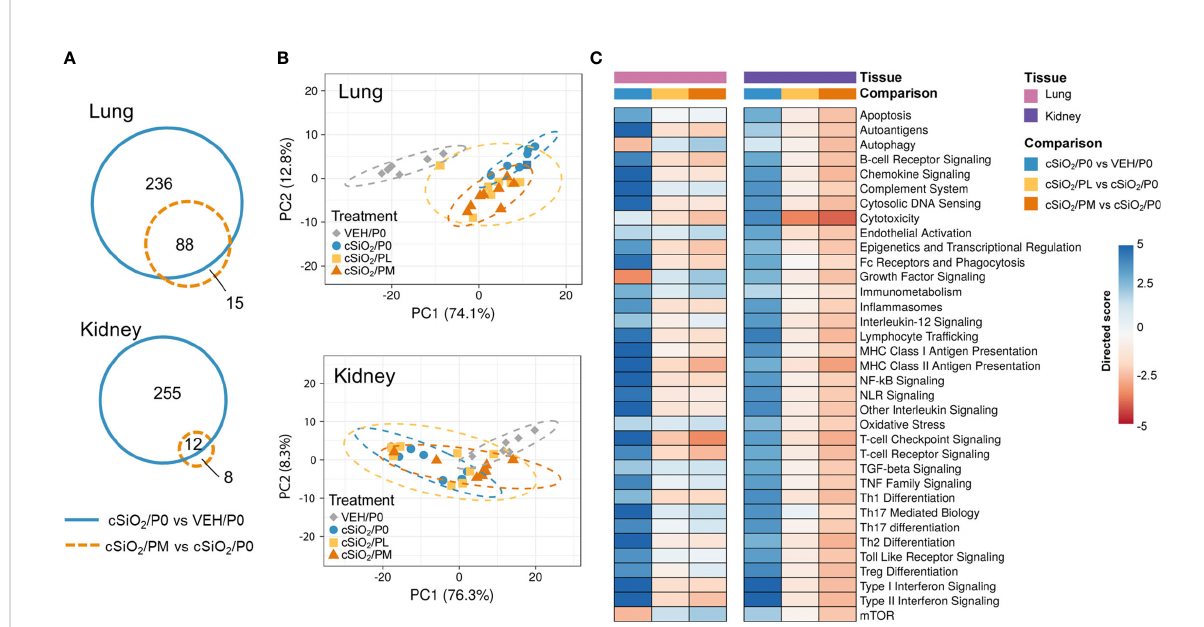
FIGURE 6 Effect of prednisone treatment on cSiO 2 -induced transcriptional changes in lung and kidney tissues of mice 14 weeks post instillation. (A) Venn diagrams depicting overlap of genes differentially regulated in mice with cSiO 2 /P0 vs VEH/P0 treatment or cSiO 2 /PM vs cSiO 2 /P0 treatment (FDR q<0.05, 1.5-fold change). The overlap regions indicate genes affected by silica exposure that were also differentially regulated with moderate-dose prednisone. No signi fi cant differentially expressed genes were identi fi ed when comparing cSiO 2 /PL to cSiO 2 /P0 for either lung or kidney. (B) Principal components analyses of differentially expressed genes in lung and kidney tissues of mice with low- (cSiO 2 /PL) or moderate-dose prednisone (cSiO 2 /PM) as compared to VEH/CON and cSiO 2 -exposed (cSiO 2 /P0) tissue-matched control diets. PC1 and PC2 are shown with 95% con fi dence intervals (dashed ellipses). (C) Directed signi fi cance scores for autoimmune pathways were determined using nSolver (see Materials and Methods) by comparing cSiO 2 /P0 to tissue-matched VEH/P0 control group or by comparing cSiO 2 /PL or cSiO 2 /PM treatments to tissue matched cSiO 2 /P0 treatment group. cSiO 2 , crystalline silica; P0, zero prednisone; PL, low-dose prednisone; PM, moderate- dose prednisone; VEH, vehicle